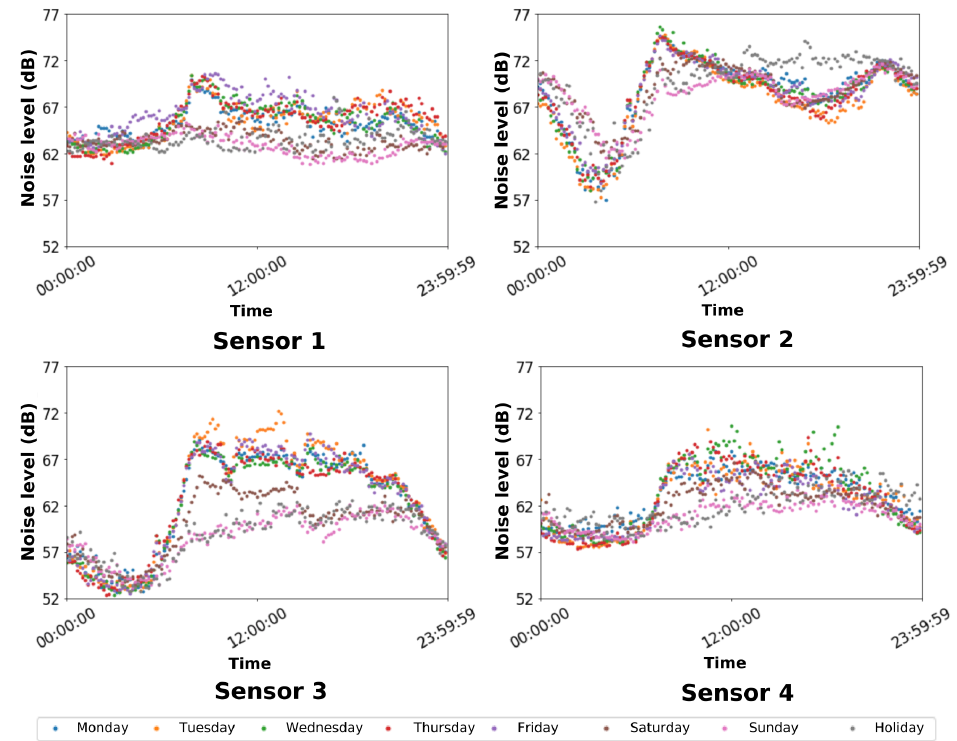
Figure 8. Average noise level sensed over the day grouped by the week days and